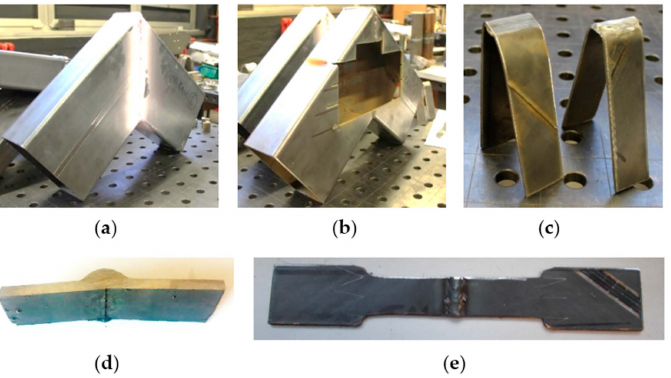
Figure 5. Performed testing procedures of butt welds between the beam and the column: ( a ) dye penetration test; ( b ) sample extraction; ( c ) bending test; ( d ) macrograph analysis; ( e ) static tension